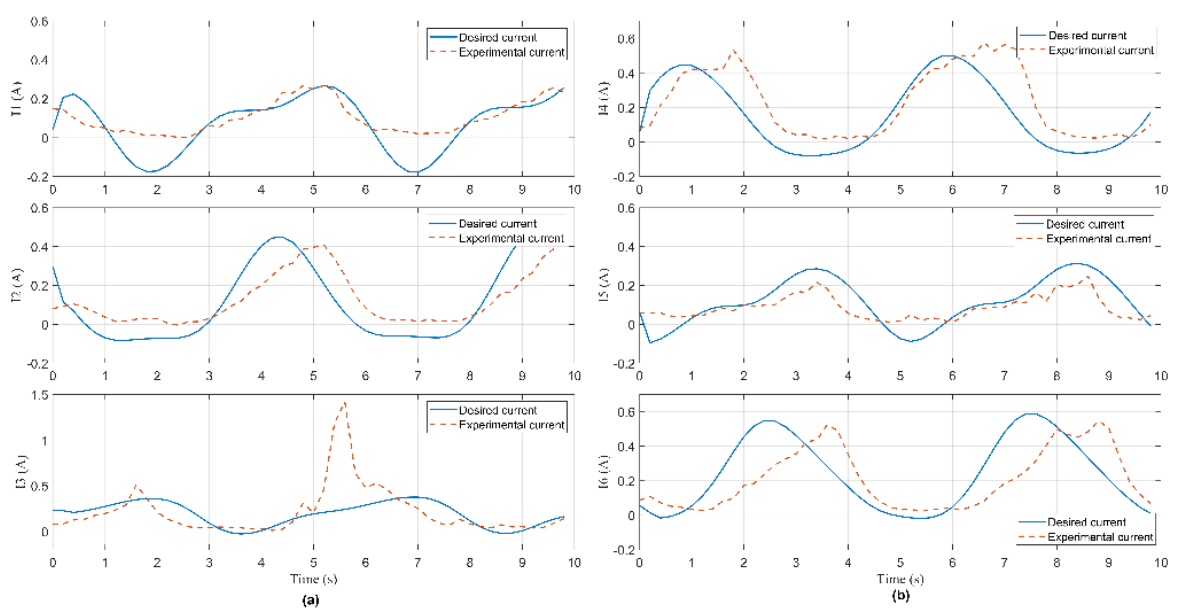
Figure 15. Current signal measured from current sensors in Case 2: (a) The 1 st , 2 nd , and 3 rd sensor; (b) the 4 th , 5 th , and 6 th sensor.